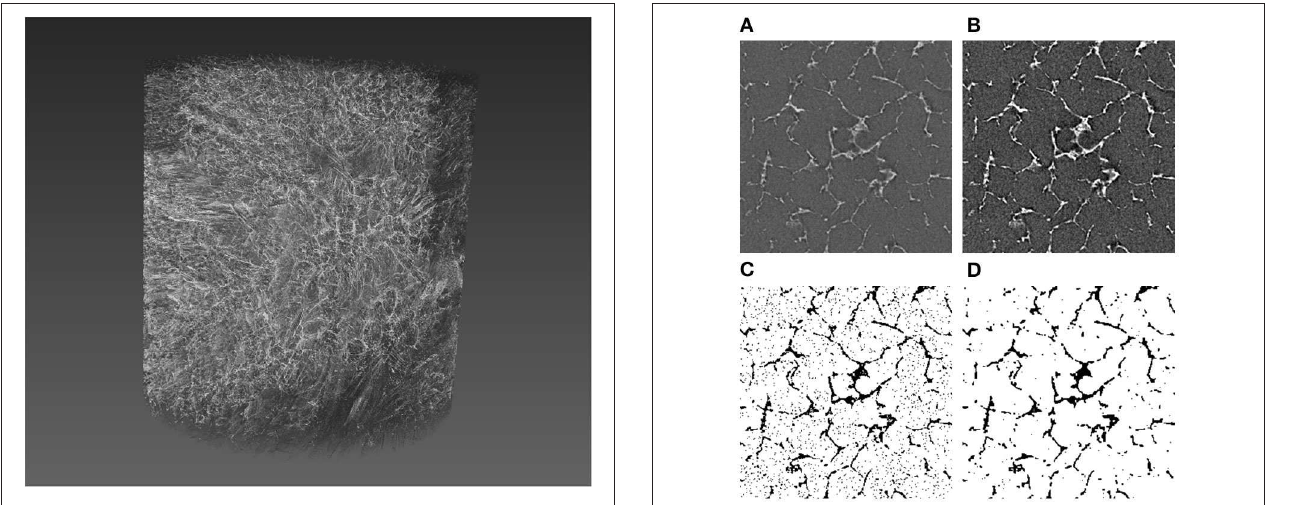
FIGURE 3 | Image processing algorithm for CT images. (A) The original image, (B) the adjusted brightness, (C) the thresholded image, and (D) the final noise-free image. The bright areas represent the silk in (A,B) . In the binarized images (C,D) , the dark areas represent the silk. the sponge scaffolds to its physical dimensions. The tortuosity in the XY plane was defined relative to the diameter of the sponge scaffold; the tortuosity in the Z-direction was defined relative to the sponge scaffold height. The ANOVA was significant for both tortuosities for silk concentration, but only significant in the XY-plane for the process